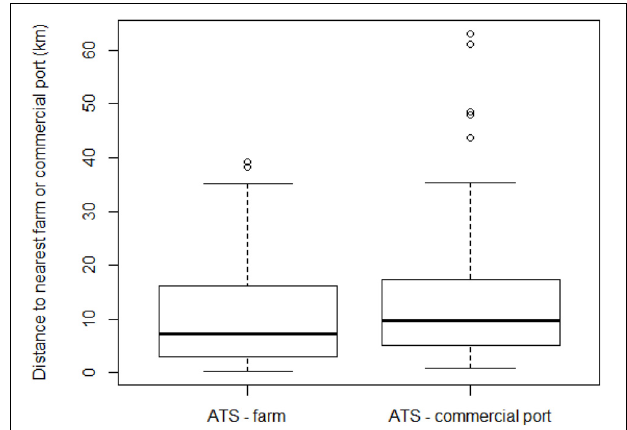
FIGURE 2 | Boxplot of distance of Abnormally Tough Specimen (ATS) observations to the nearest farm or commercial port, with median, first and third quartiles (boxes), least values (dotted bars), and outliers (dots).